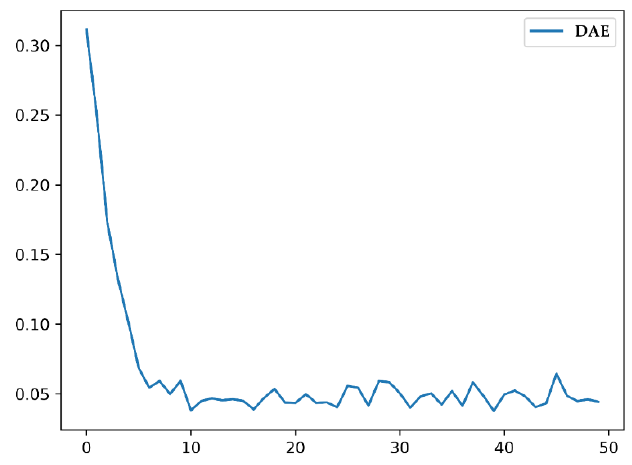
Figure 8. The training loss of DAE model.